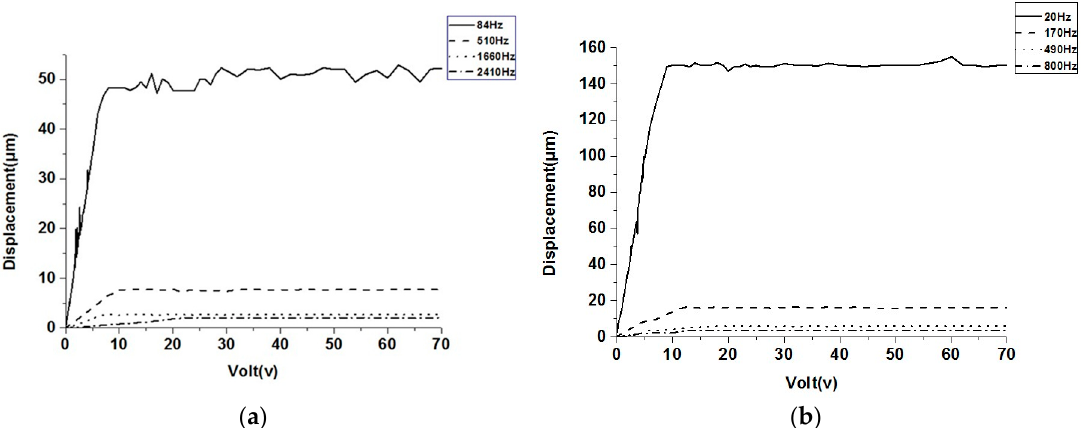
Figure 17. Variations in displacement with excitation voltage for first four modes under ( a ) air-coupled